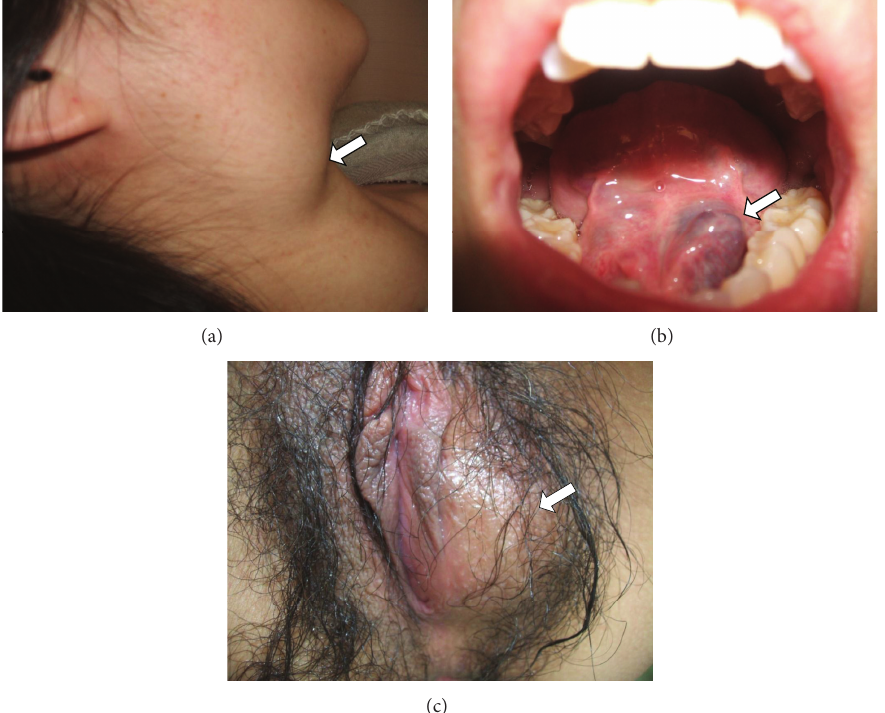
Figure 1: Venous malformations in pregnancy. Multiple venous malformations were observed on the patient’s (a) neck (arrow), (b) floor of the mouth (arrow), and (c) vulva (arrow).